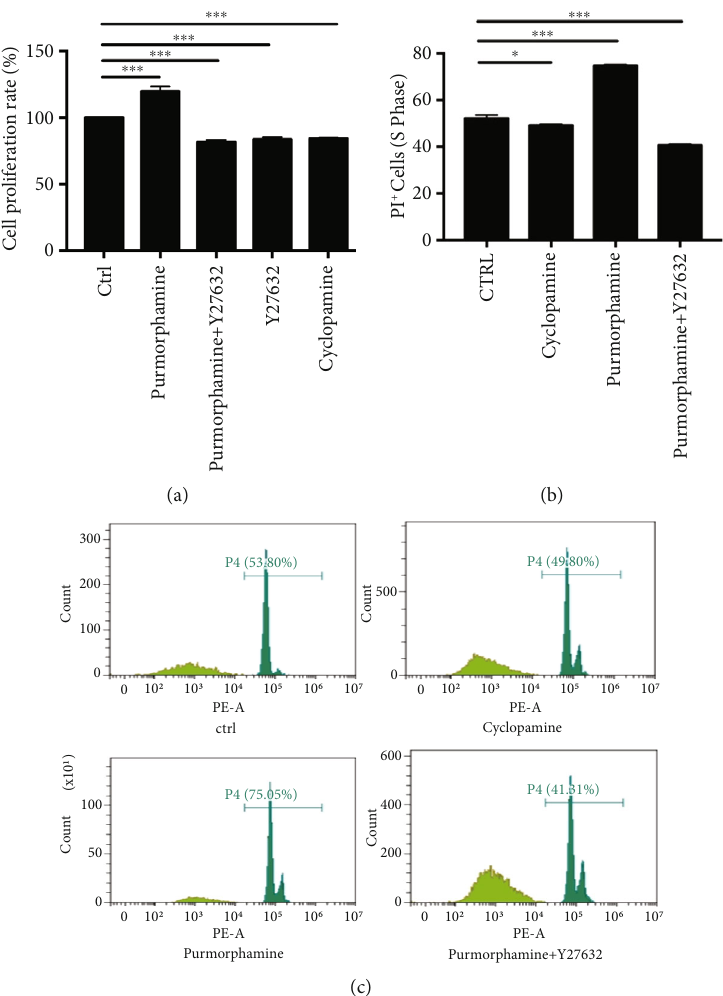
Figure 4: Shh signaling promotes the proliferation of RA-FLS via the Rho/ROCK pathway. (a) RA-FLS were treated with purmorphamine, purmorphamine combined with Y27632, Y27632, or cyclopamine for 48 h. The cell proliferation rate was measured with a CCK8 assay. (b, c) RA-FLS were treated with purmorphamine, purmorphamine combined with Y27632, or cyclopamine for 48 h, and the proportion of cells in the S phase was detected by fl ow cytometry. ∗ p < 0 : 05 , ∗∗∗ p < 0 : 001